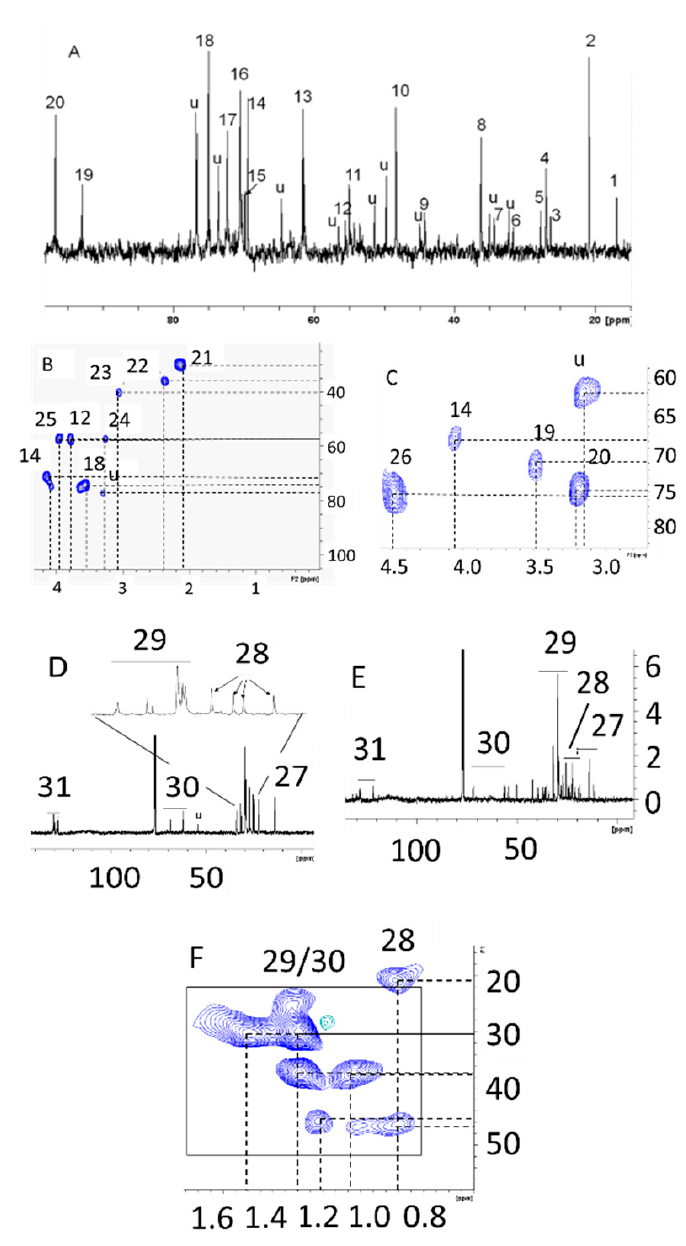
Figure 1. Representative NMR spectral profile from uninfected healthy control Balb / c mouse after infusion of (2 13 C)glucose through tail vein. ( A ) 1-dimensional 13 C NMR profile of hydrophilic extract of liver; ( B , C ) 2-dimensional HSQC profiles of hydrophilic extracts of red blood cells (RBCs) and brain, respectively; ( D , E ) 1-dimensional 13 C NMR profile of hydrophobic extracts of liver and brain, respectively; ( F ) 2-dimensional HSQC profile of hydrophobic extract of RBC. Keys: 1-C3-alanine, 2-C2-lactate, 3-C3-N-acetylcysteine, 4-C3-glutamine, 5-C2-acetate, 6-C4-glutamine, 7-unidentified, 8-C2-taurine, 9-guanidoacetate, 10-C1-taurine, 11-Choline (N-CH 3 ), 12 ‐ C2 ‐ alanine, 13 ‐ C6 ‐ glucose ( α + β ), 14 ‐ C2 ‐ lactate, 15 ‐ C2 ‐ cysteine, 16 ‐ C2 ‐ glycerol, 17 ‐ C2 ‐α‐ glucose, 18 ‐ C2 ‐β‐ glucose, 19 ‐ C1 ‐α‐ glucose, 20 ‐ C1 ‐β‐ glucose, 21 ‐ C3 ‐ glutamate, 22 ‐ C4 ‐ glutamate, 23 ‐ Creatine (N ‐ CH 3 ), 24 ‐ betaine (N ‐ CH 3 ), 25 ‐ C2 ‐ Creatine, 26 ‐ C2 ‐ 2,3 ‐ BPG,27 ‐ cholesterol CH 3 , 28 ‐ cholesterol/fatty acid CH2, 29 ‐ fatty acid/TG CH 2 , 30 ‐ long chain TG Glycerol CH 2 , 31 ‐ long chain fatty acid unsaturated carbon. 2.2. Alteration in Glucose Utilization of RBC Previously, our group has shown that ~5% of P. falciparum ‐ infected RBCs significantly impact glucose utilization from uninfected RBCs from the same culture [14]. In P. falciparum infections, the parasitemia in patients typically remains far less than 5%, whereas in the rodent model of Plasmodium berghei infection the parasitemia reaches 20% to 40%. Therefore, ~1% infection in this rodent model does indicate a very early stage, and it was interesting to note that the labeling pattern in the RBC was distinct even when the mice had ~1% parasitemia, compared to that of the uninfected control animals. Principal component analysis (PCA) of the hydrophilic fraction of RBCs showed variation along the first principal component (PC1 R 2 X = 0.48) as did orthogonal partial least square discriminant analysis (OPLSDA) modeling (Q 2 (cum) = 0.55). This is evident from the score plots (Figure 2A,B). The extent of labeling in the (2 ‐ 13 C)2,3 ‐ bisphosphoglycerate was found to decrease in the infected animals (Figure 2C). On the other hand, the hydrophobic fraction of RBCs showed significant variations, which were captured along the PC2 (R 2 X = 0.23 of the PCA scores) (Figure 2D).